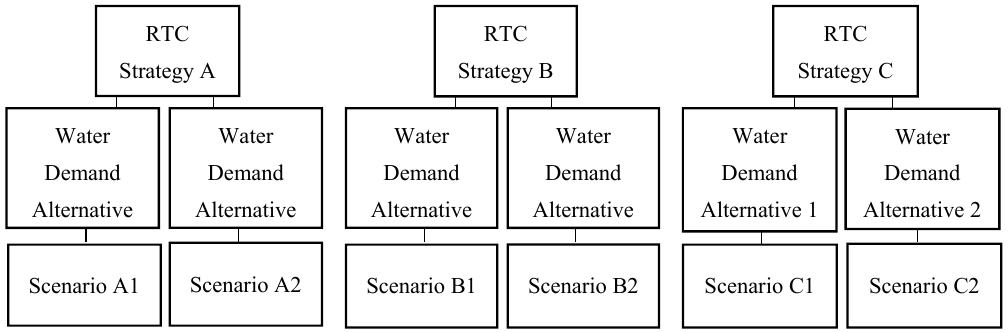
Figure 3. The six SWH Scenarios—RTC Strategy and Water Demand Alternative (WDA)—modelled.